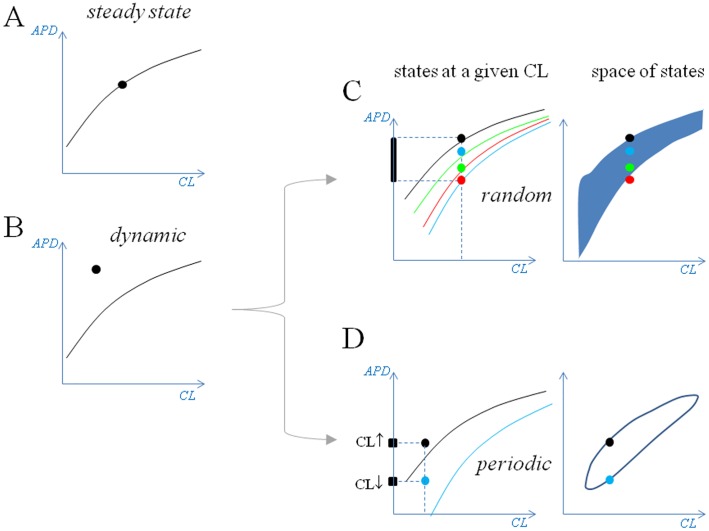
States and space of states.The steady-state of the paced membrane can be described as a CL,APD point lying on its ER curve (A), whereas in dynamic pacing conditions the state does not belong to its ER curve (B) in general. (C) If pacing CL changes randomly, for each CL (vertical broken line) the system can assume an infinite number of states between the lower and upper ER curves of the family (red and black dots respectively); the space of allowed states fills the entire blue area on the right-hand panel. (D) If pacing CL changes periodically, for each CL the system can assume only 2 states, depending on whether CL is increasing (CL↑) or decreasing (CL↓), leading to a closed curve as a space of states (right-hand panel).